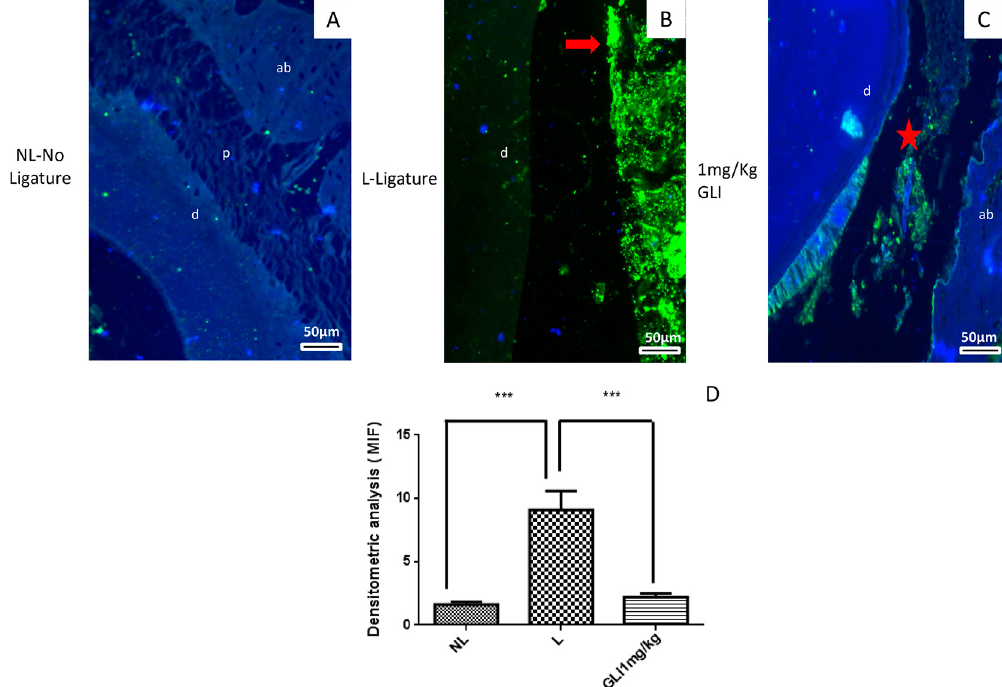
Figure 6- Gliclazide (GLI) modulates macrophage migration inhibitory factor (MIF) expression. Representative confocal photomicrographs of MIF immunoreactivity in periodontal specimens from each group (green) with DAPI nuclear counterstaining (blue). (A) Sample from the no ligature group showing discrete MIF labeling in dentin (d), periodontium (p), or alveolar bone (ab); (B) Sample from the ligature group shows strong labeling (red arrows) in the periodontal area. (C) Sample from the 1 mg/kg GLI group showing diffuse, weak MIF labeling (red star). Scale bar 50 µm, 200× magnification. (D) Densitometry analysis confirmed significantly decreased MIF immunoreactivity in the 1 mg/ kg GLI group, which was blocked in the ligature group. Five immunofluorescence sections from each animal (n=3/group) were